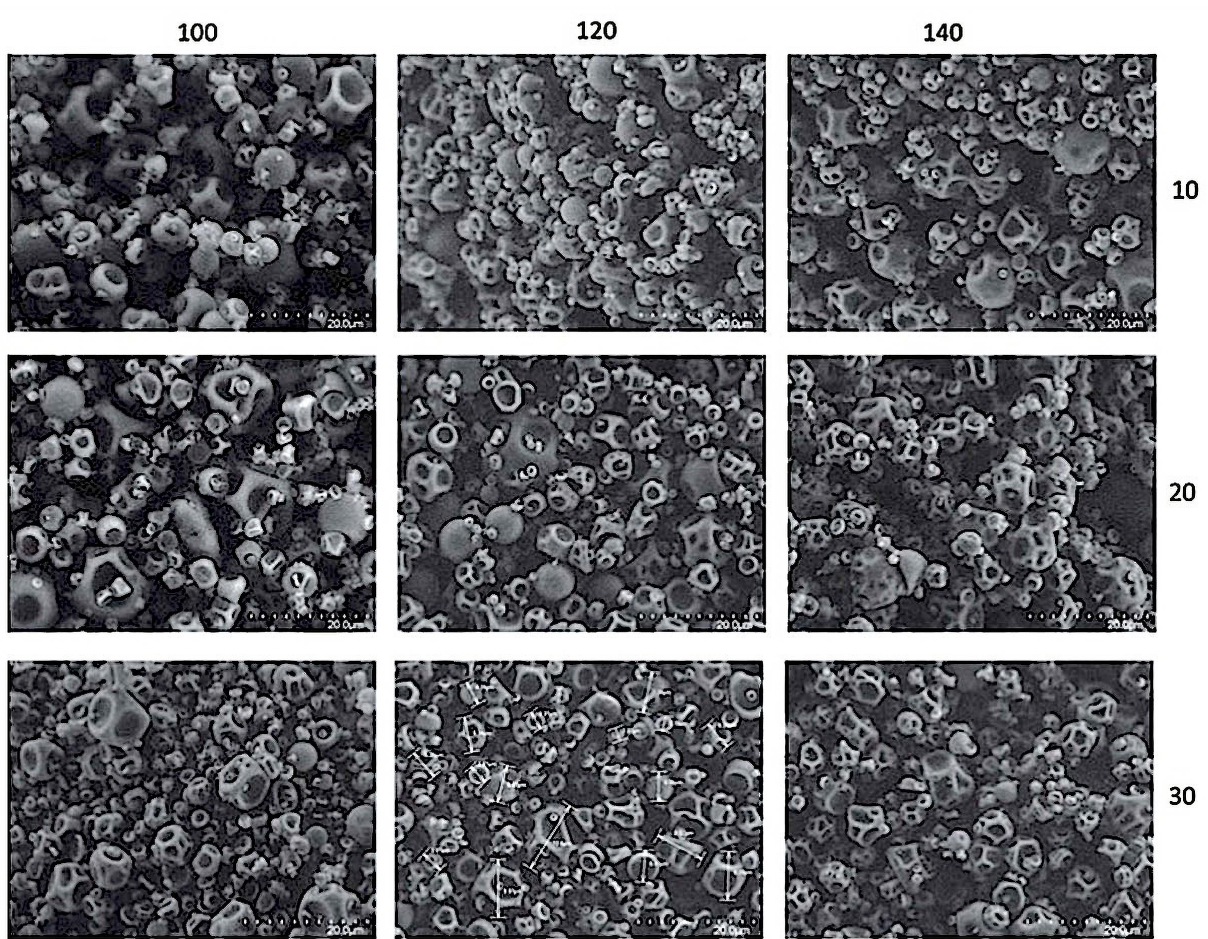
Figure 1. SEM images of spray-dried calafate berry powders. Three doses of maltodextrin and three inlet temperatures. Rows belong maltodextrin percentage (10, 20, 30) while columns correspond to inlet temperature of the spray dryer (100 °C, 120 °C, 140 °C).